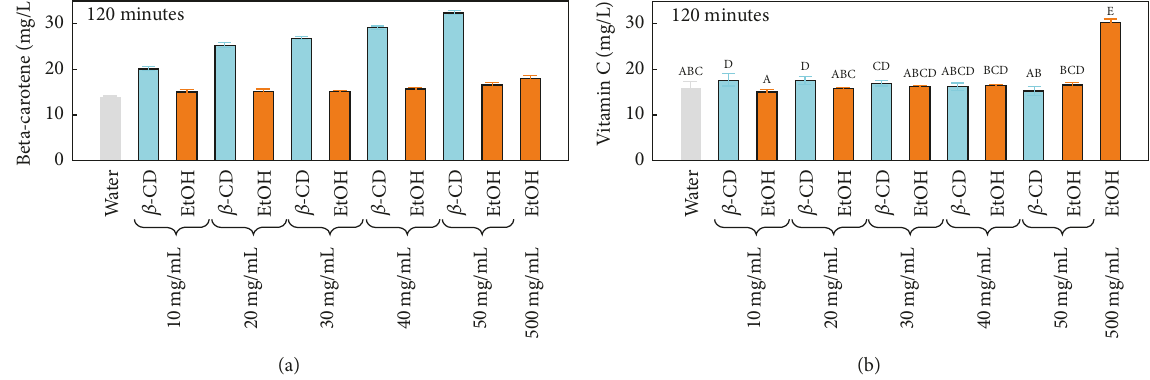
Figure 3: Comparison of (a) beta-carotene and (b) vitamin C recovery using 𝛽 -CD and EtOH at the same concentrations after 120 minutes of extraction. Different superscript letters indicate significant statistical difference ( 𝑝 < 0.05